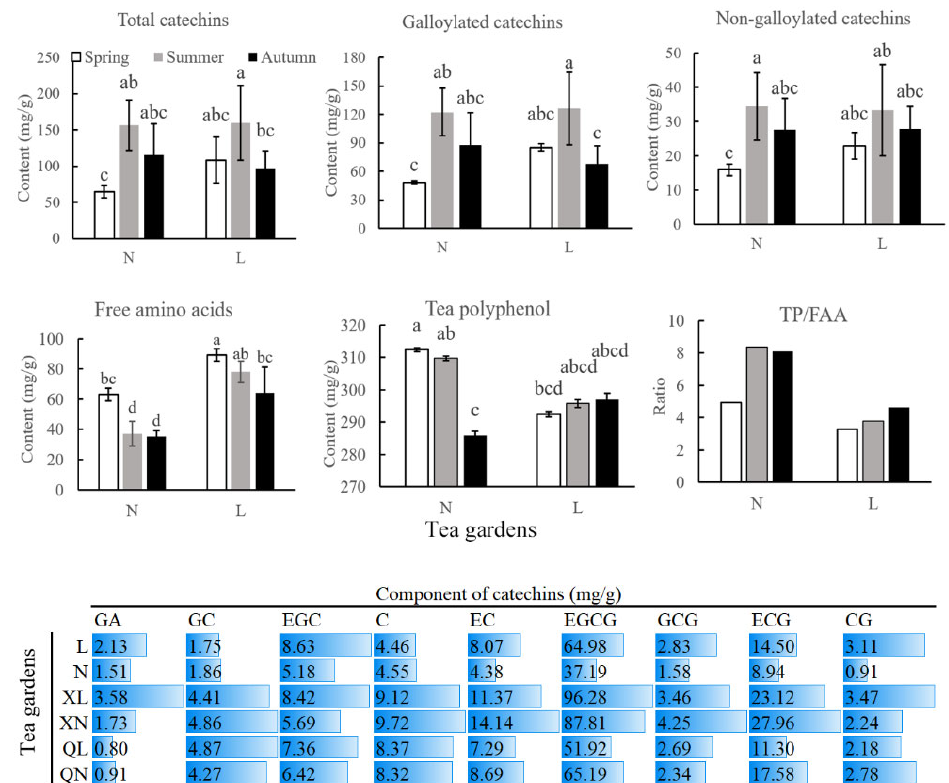
Figure 1. Flavor components of Changqing tea in different seasons. Different lowercase letters represent different significantly on p < 0.05 level. N, XN, and QN mean samples from Nanhuyulu in spring, summer and autumn, respectively. L, XL, and QL mean samples from Litaishan in spring, summer and autumn, respectively. GA, gallic acid; GC, gallocatechin; EGC, epigallocatechin; C, catechin; EC, epicatechin; EGCG, epigallocatechin gallate; GCG, gallocatechin gallate; ECG, epicatechin gallate; CG, catechin gallate; TP, tea polyphenol; FAA, free amino acids.